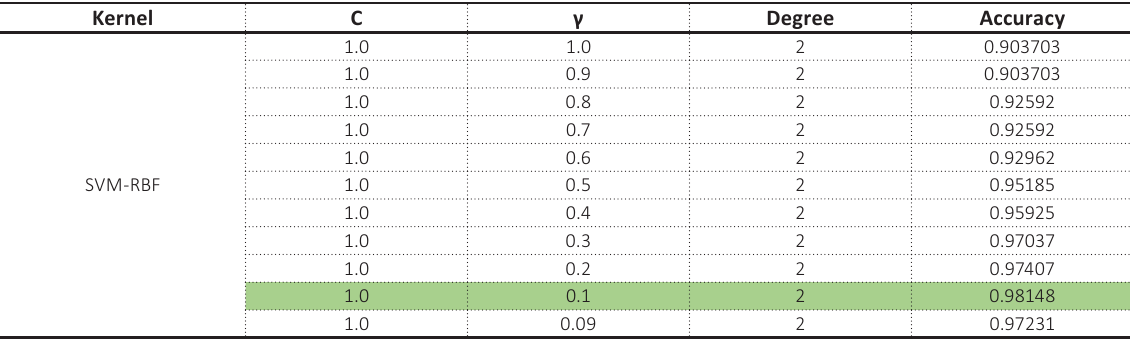
Table A5. Test of the SVM-RBF parameters by the Gird-Search function Kernel C